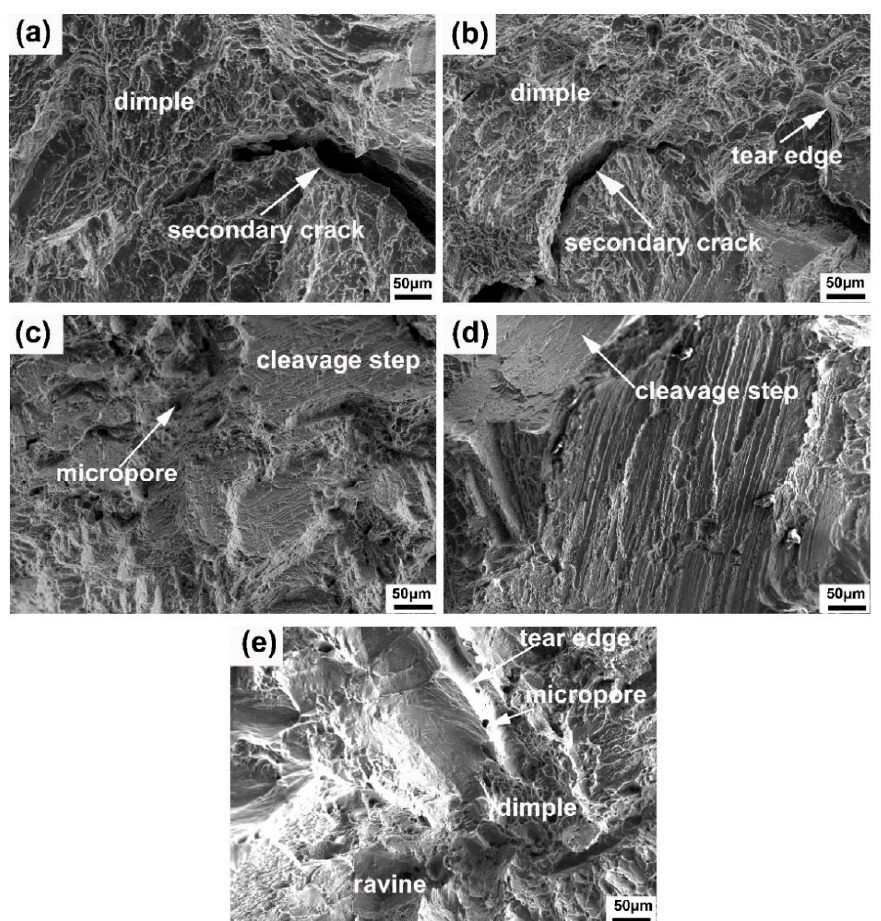
Figure 12. SEM images of fracture surface of heat-treated TC4F. Samples ( a ) 1, ( b ) 2, ( c ) 3, ( d ) 4, and ( e ) 5.